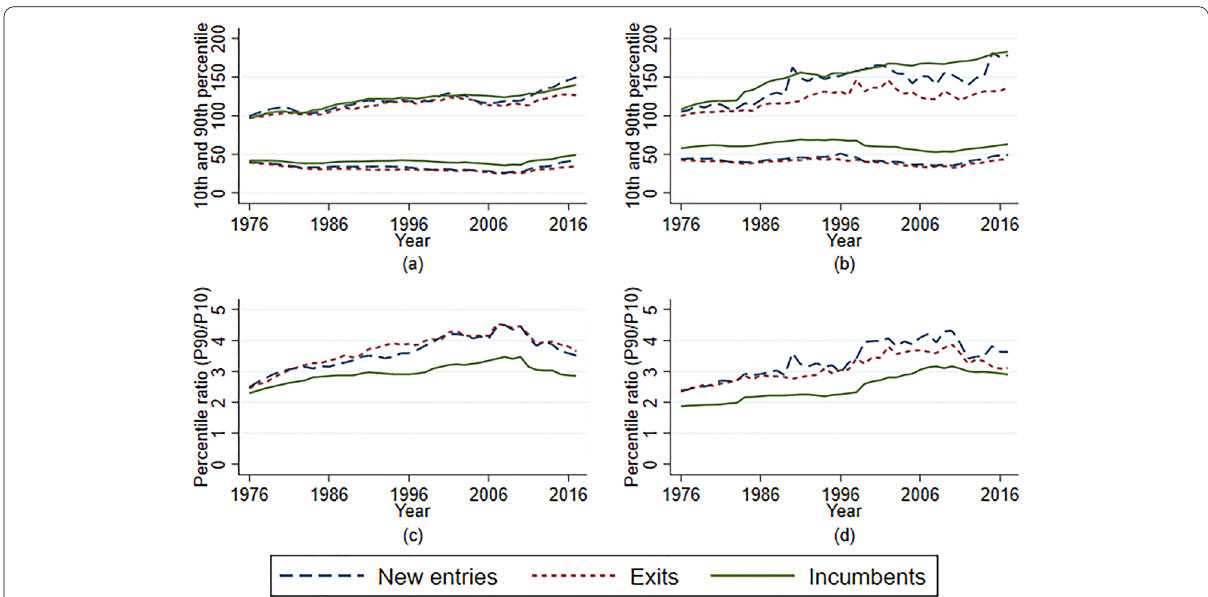
Fig. 11 Wage dispersion dynamics of entering, exiting and incumbent establishments. a Shows 10th and 90th percentile of the average wage distribution, not weighted by establishment size. b Shows the 10th and 90th percentile of the average wage distribution, weighted by establishment size. c Shows the ratio between 10 and 90th percentile, not weighted by establishment size. d Shows the ratio between 10 and 90th percentile, weighted by establishment size